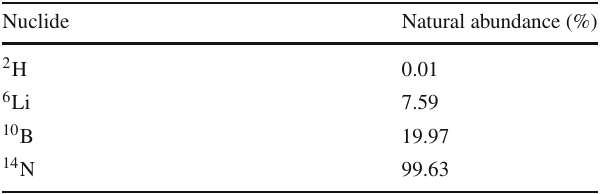
Table 1 Stable nuclides with odd-numbered neutrons and protons and non-zero nuclear spin Nuclide Natural abundance